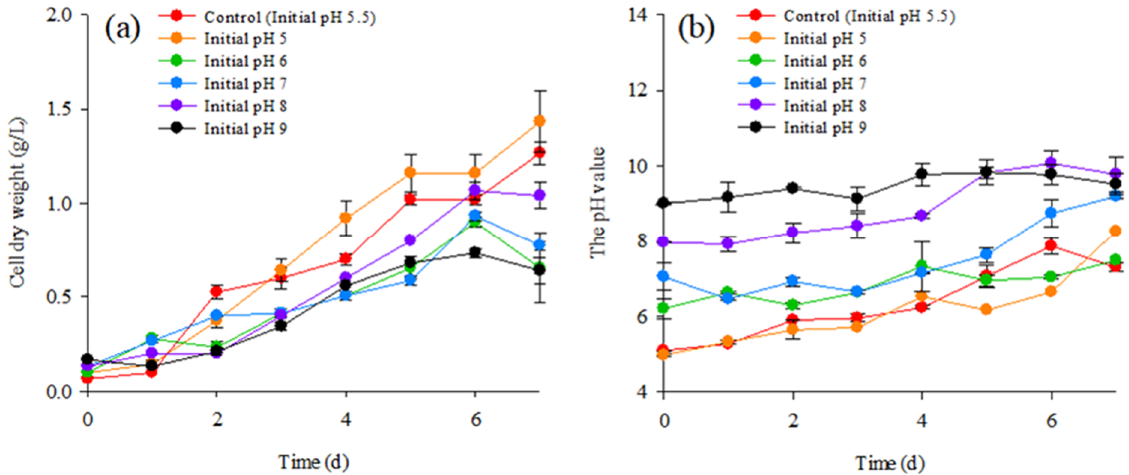
Figure 2. Effect of initial pH on ( a ) biomass production and ( b ) medium pH during mixotrophic cultivation of Coelastrella sp. KKU - P1 in molasses-based medium.